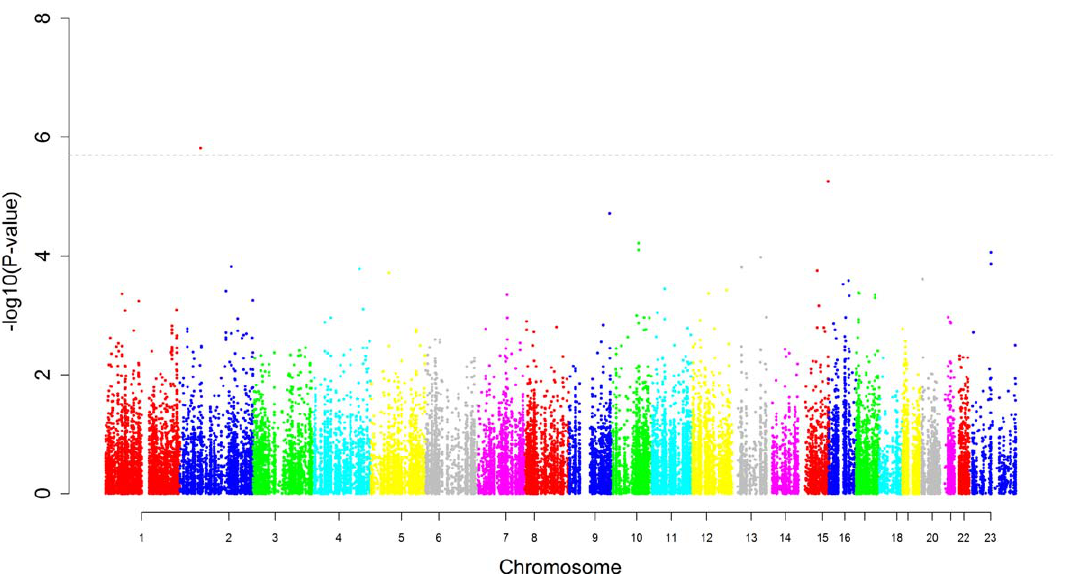
Figure 2. Manhattan plot for obstructive sleep apnea in African-Americans. This figure plots the association results for all SNPs against an apnea hypopnea index of 15 or greater among African-Americans. The y-axis displays the -log(p-value), the x-axis the SNP position on each chromosome. The dotted line represents the threshold for statistical significance based on the number of independent comparisons being made.